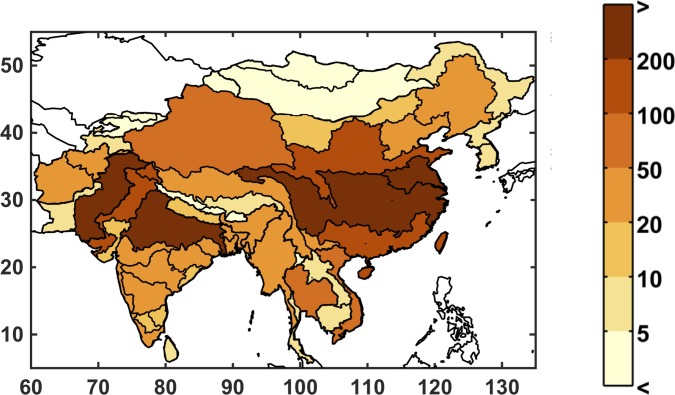
Baseline irrigation requirement (in billion cubic meters)